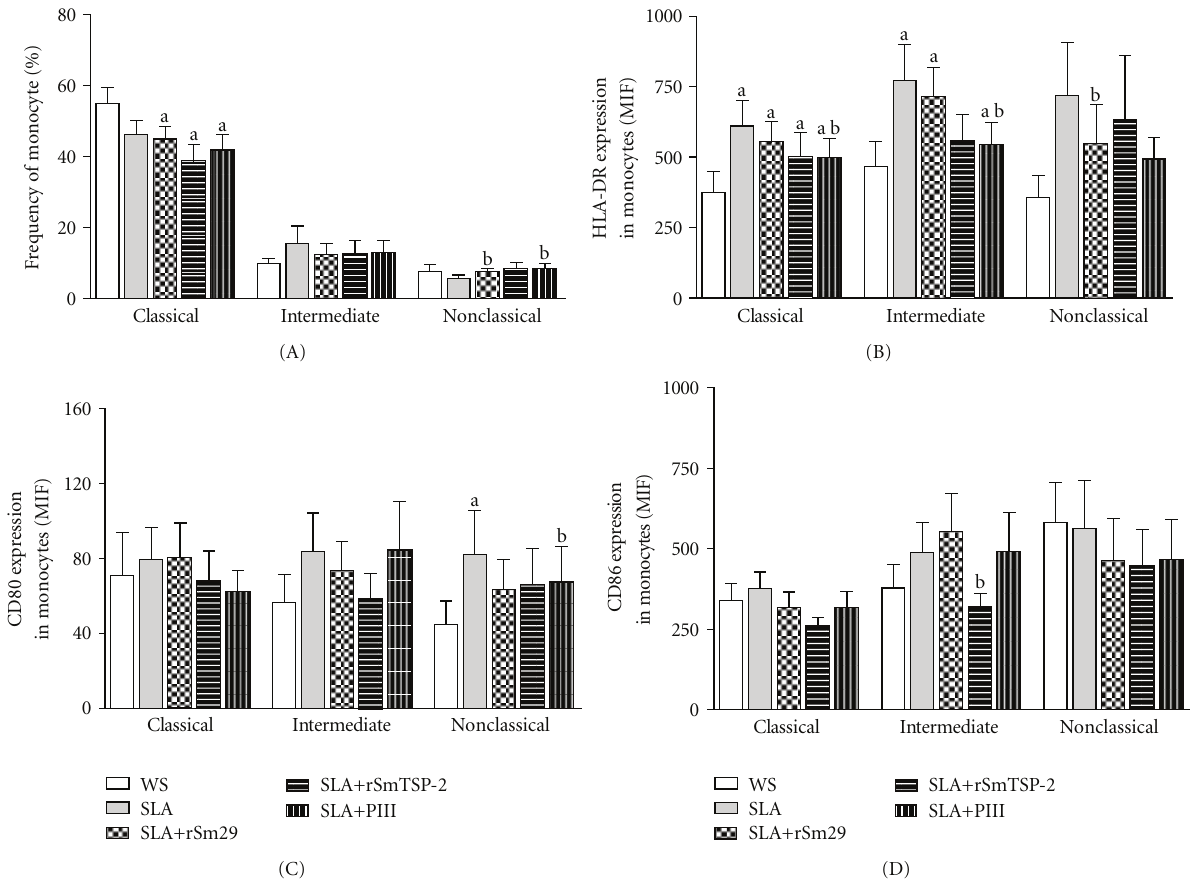
Figure 2: Subsets of monocytes and co-stimulatory molecules expression in monocytes of CL patients ( n = 18) stimulated in vitro with SLA in the presence or absence of S. mansoni antigens rSm29 and rSmTSP-2 or with a fraction of S. mansoni soluble adult worm antigen (SWAP) PIII. Frequency of classical (CD14 ++ CD16 − ), intermediate (CD14 ++ CD16 + ) and nonclassical (CD14+CD16 ++ ), monocytes (A), and expression of HLA-DR, CD80, and CD86 in classical, intermediate and nonclassical monocytes of cutaneous leishmaniasis patients (B– D). Cells were stained for surface expression of CD14, CD16, HLA-DR, CD80, and CD86 using flow cytometry. a P < 0 . 05 cultures without stimulation (WS) versus SLA + S. mansoni antigens; b P < 0 . 05 SLA versus SLA + S. mansoni antigens (Wilcoxon matched pairs